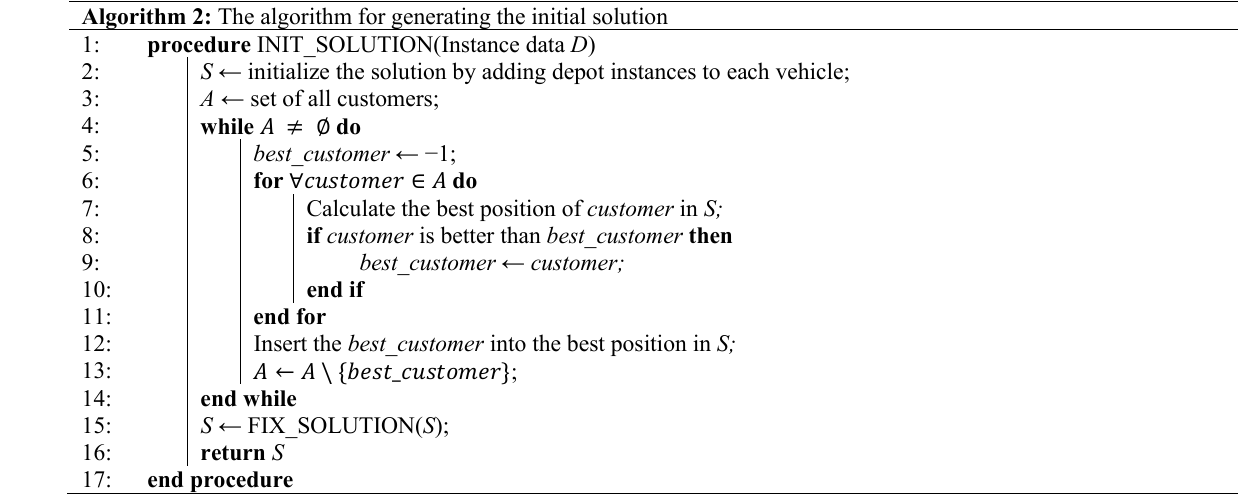
Algorithm 2: The algorithm for generating the initial solution